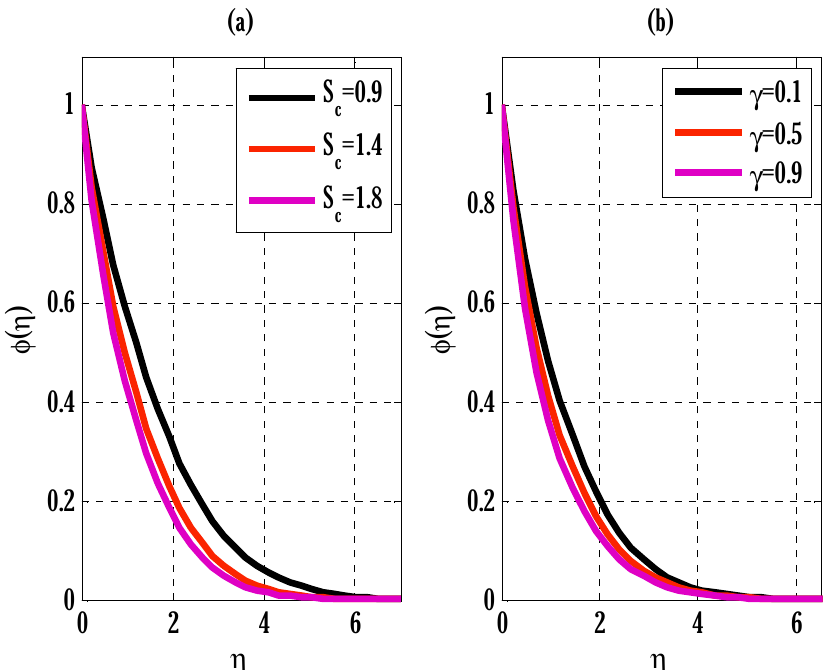
Figure 6. Variation of thermophoresis and Brownian motion parameters on concentration profile using 𝑁 = 30, 𝛽 = 3, 𝜆 = 0.1, 𝐹 (cid:3045) = 0.1, 𝑀 = 0.1, 𝐸 (cid:2869) = 0.01, 𝐵𝑖 = 0.1, 𝐸 (cid:3030) = 0.3, 𝑅 (cid:3031) = 0.1, 𝑃 = 1.7, 𝑆 = 1.5, and 𝛾 = 0.9. (𝐚) 𝑁 (cid:3045) (cid:3030)